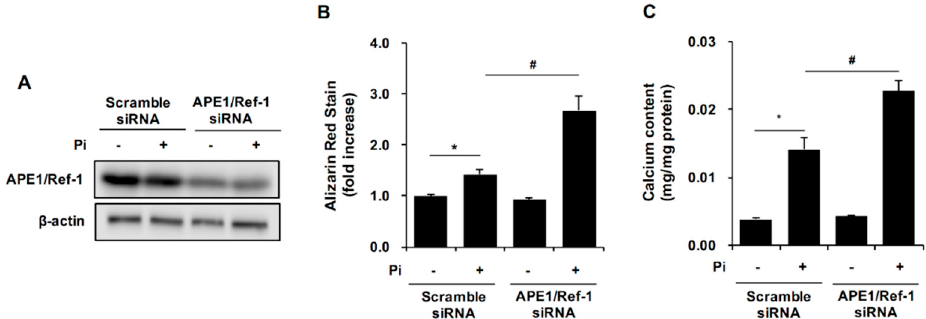
Figure 3. Gene silencing of APE1/Ref-1 increased inorganic phosphate (Pi)-induced calcification in vascular smooth muscle cells (VSMCs). ( A ) Representative Western blot results of APE1/Ref-1 gene silencing. After transfection with small-interfering (si)RNA for APE1/Ref-1, VSMCs were incubated with Pi (5 mM) for 4 days; ( B ) At the end of incubation, cells were stained with 2% alizarin red S. Each bar represents the mean ± standard error of the mean (SEM) ( n = 5). * p < 0.05 vs. control; # p < 0.05 vs. Pi alone by one-way ANOVA; ( C ) Calcium-deposition assay using the same conditions as described in ( B ). To evaluate calcium deposition, cells were decalcified by incubation for 24 h with 0.6 N HCl. The calcium content in the supernatant was determined colourimetrically using O -cresolphthalein and normalized to the protein concentration as described in the Materials and Methods. Each bar represents the mean ± SEM ( n = 5). * p < 0.05 vs. control; # p < 0.05 vs. Pi alone by one-way ANOVA.